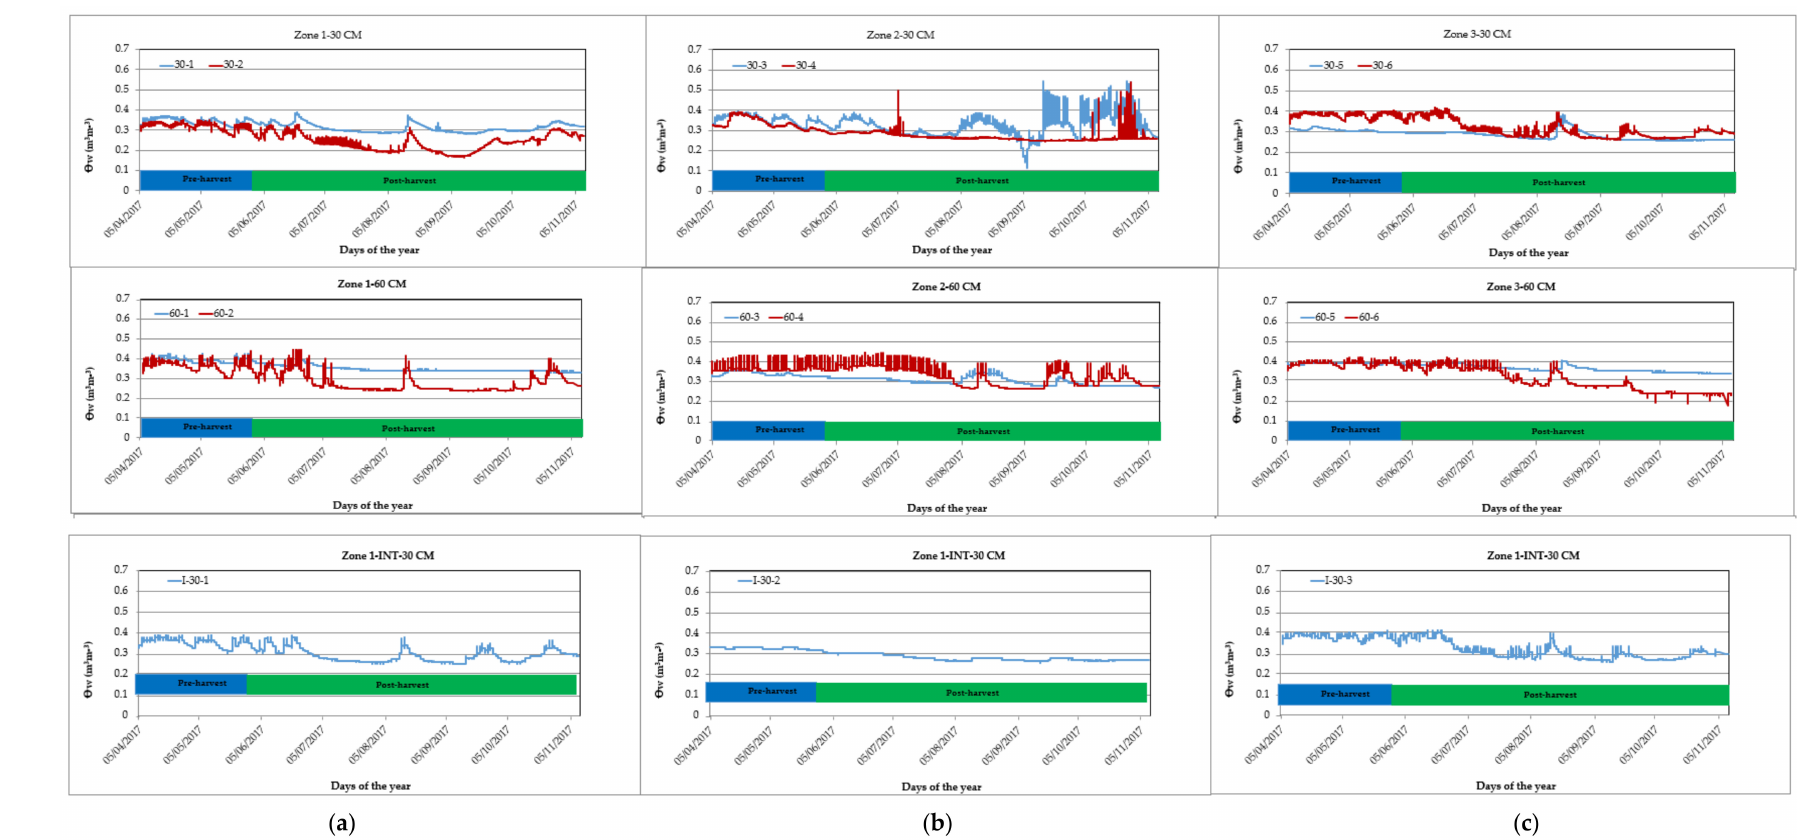
Figure 3. Data logged from the 10HS sensors in the year 2017 in the di ff erent zones: ( a ) zone 1, ( b ) zone 2, and ( c ) zone 3. Θ w = soil water; 30-1,30-2,30-3,30-4,30-5,30-6 are sensors installed at 15 cm from the dripper and at a depth of 30 cm; 60-1,60-2,60-3,60-4,60-5,60-6 are sensors installed 15 cm from the dripper and at a depth of 60 cm; I-30-1, I30-2, I-30-3 are sensors installed at a depth of 30 cm and located between drippers. Pre-harvest is the period from fruit set to harvest; postharvest is the period from harvest to onset of leaf